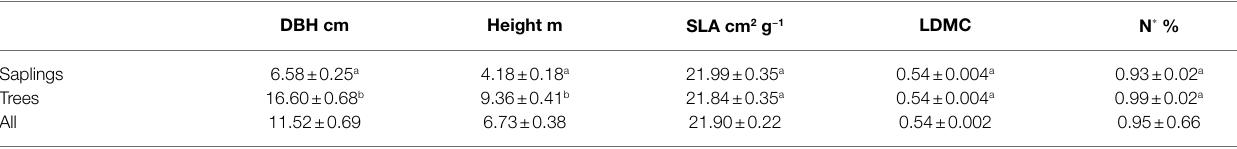
TABLE 1 | Tree and leaf characteristics of Picea glauca trees ( ≥ 10 cm DBH) and saplings (5–10 cm DBH) growing in the FTE in Alaska.